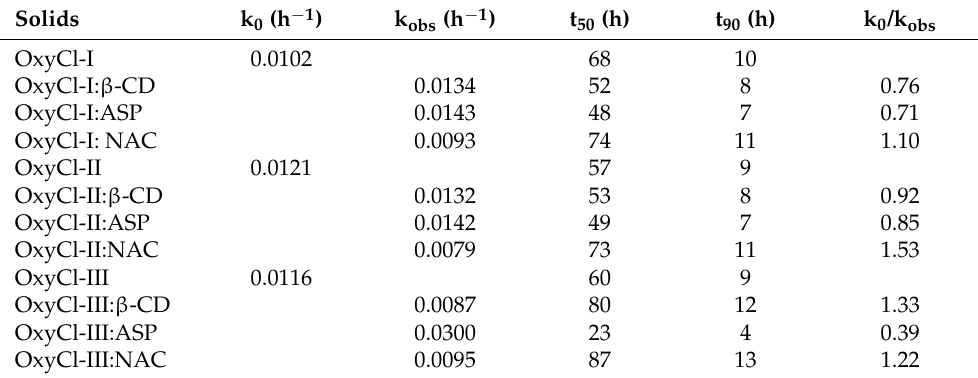
Table 4. Kinetic parameters of the degradation process in aqueous solution at 25.0 ± 0.1 ◦ C.